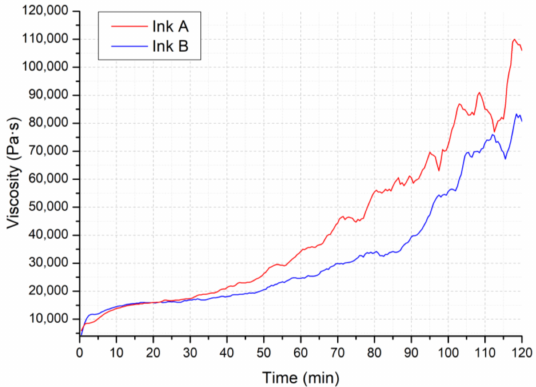
Figure 3. Viscosity η (Pa · s) against time t (min) of Ink A and Ink B under constant shear rate γ (cid:48) = 0.01 1/s over 2